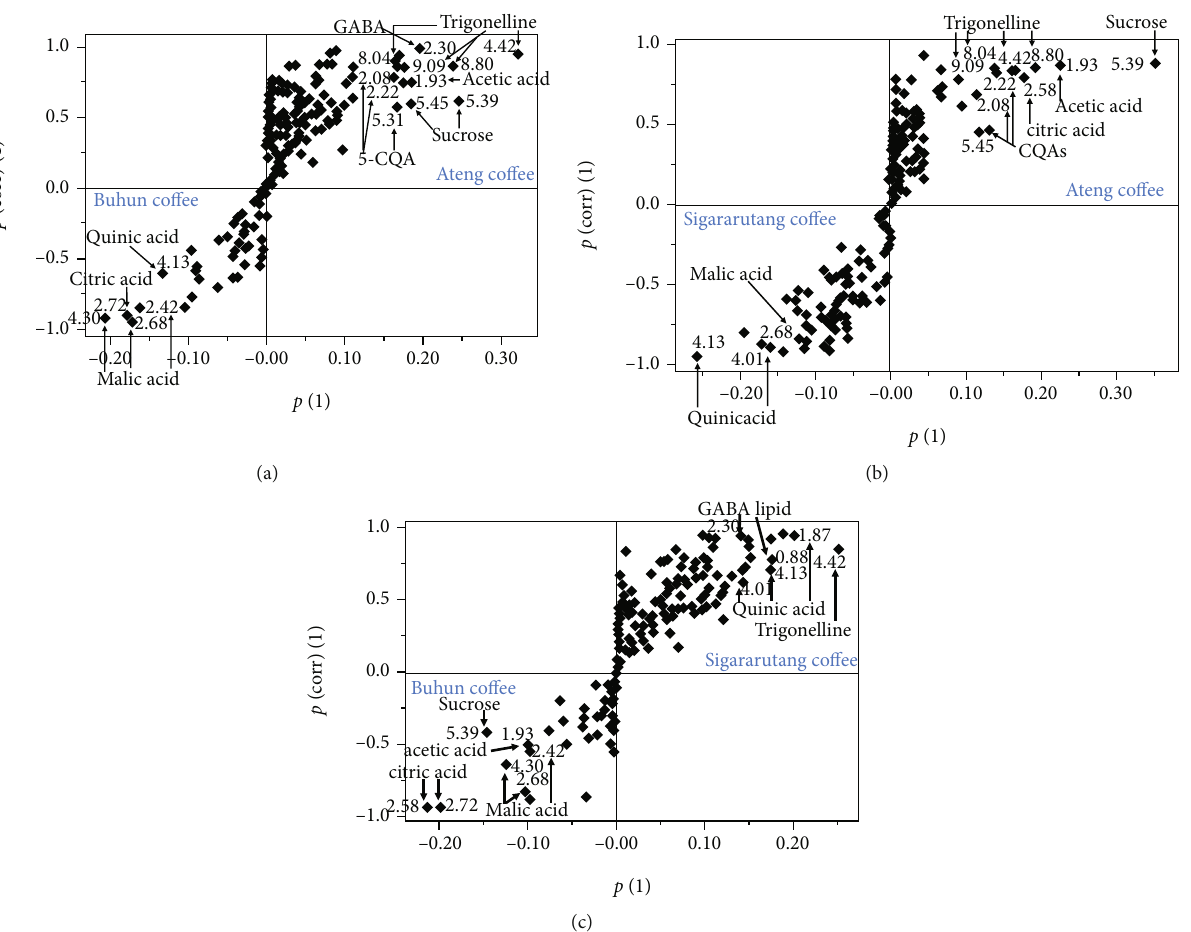
Figure 4: S-plots of two-class OPLSDA models of the green beans of the three Indonesian arabica co ff ee varieties: (a) ateng and buhun, (b) ateng and sigararutang, and (c) buhun and